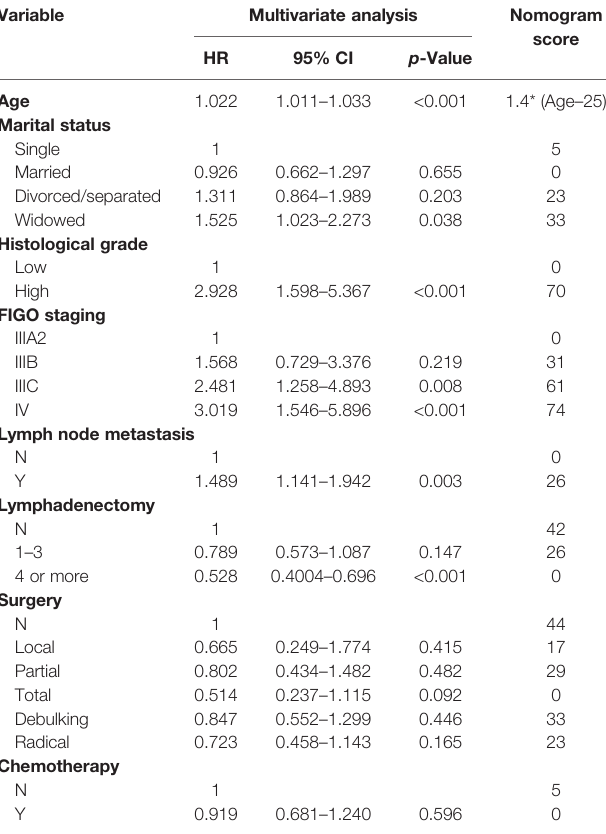
TABLE 2 | Multivariate Cox regression analysis and nomogram score of variables in the nomogram. Variable Multivariate analysis